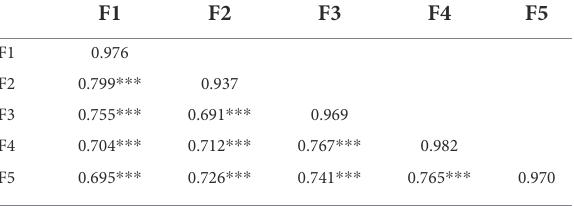
TABLE 6 Pearson’s correlation and AVE square root